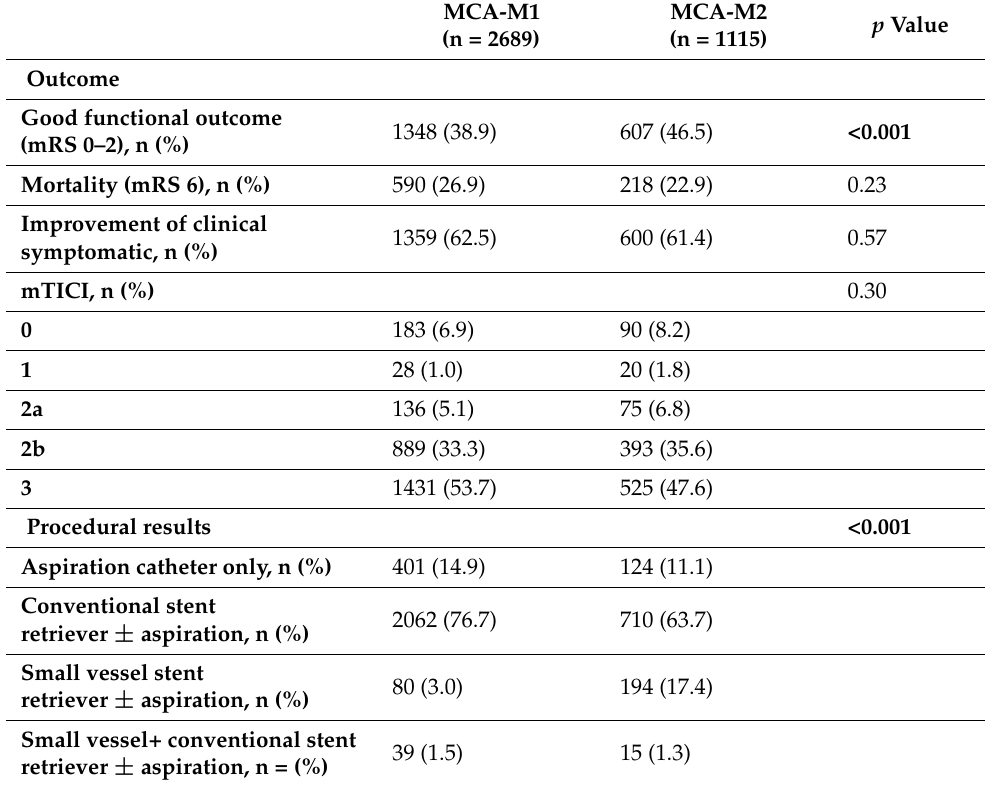
Table 2. Outcomes at 90 days, procedural results, and safety